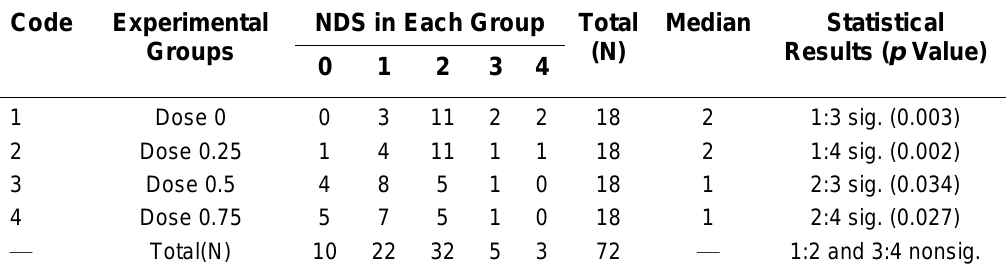
Distribution of NDS in Each